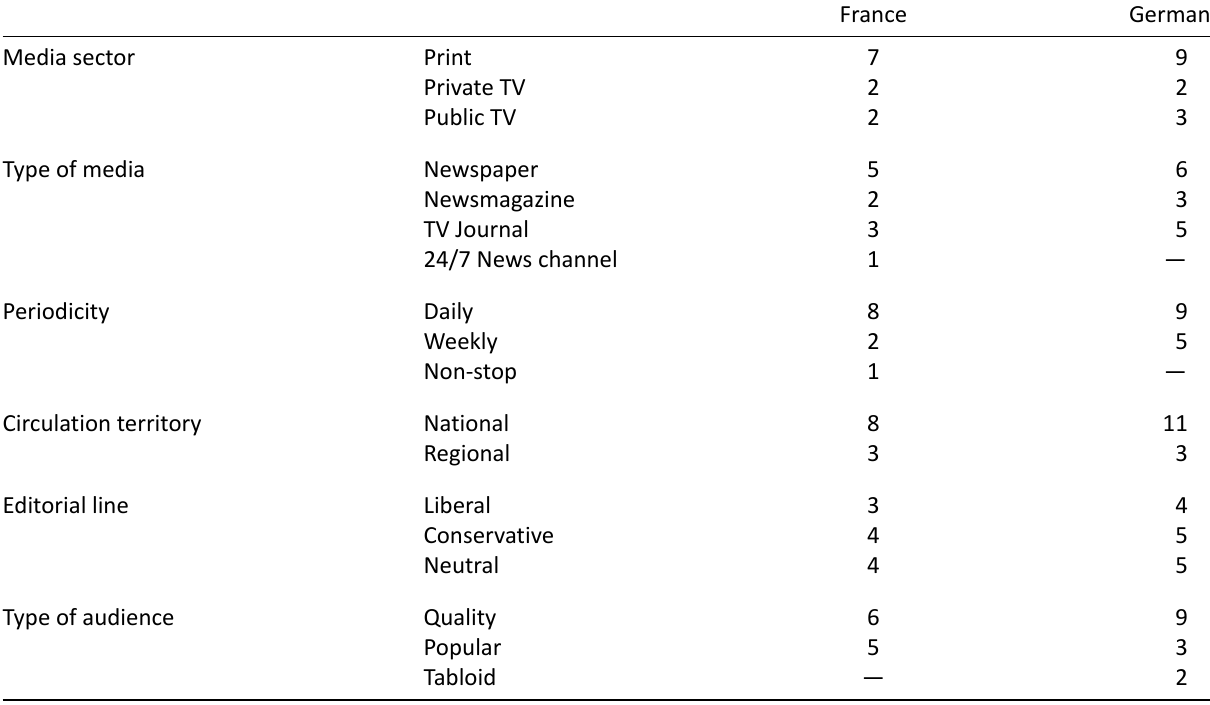
Table 2. Type of media selected in both countries, according to the six criteria used for the